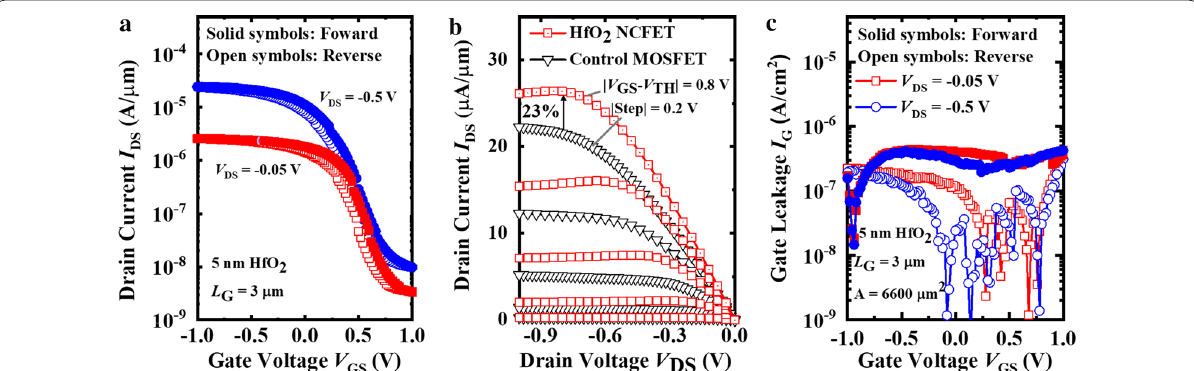
Fig. 3 a Measured I DS – V GS curves of the 5 nm HfO 2 NCFET when V DS the control MOSFET. c Measured I G – V GS curves of the 5 nm HfO 2 NCFET when V DS